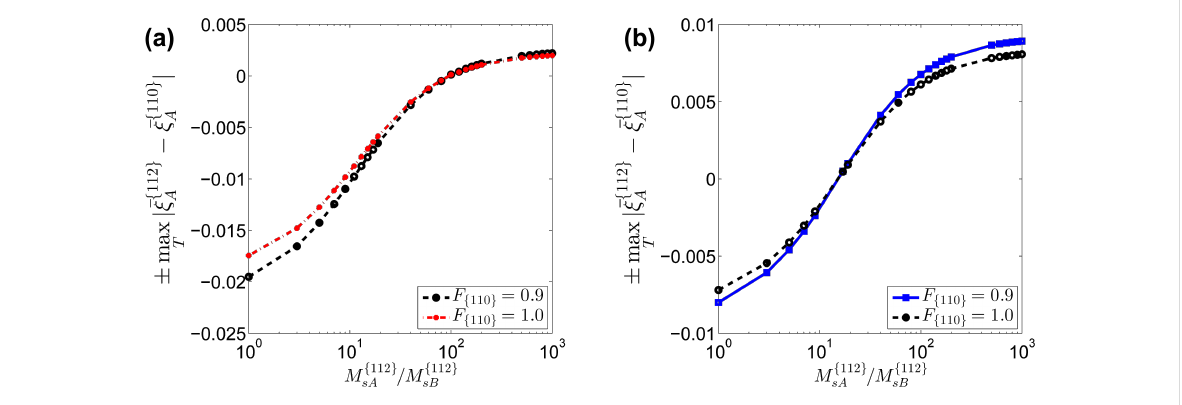
Figure 11: Influence of the ratio between the mobilities of different atoms and deposition rates on the surface concentration segregation. “+” means whereas “ − ” means .